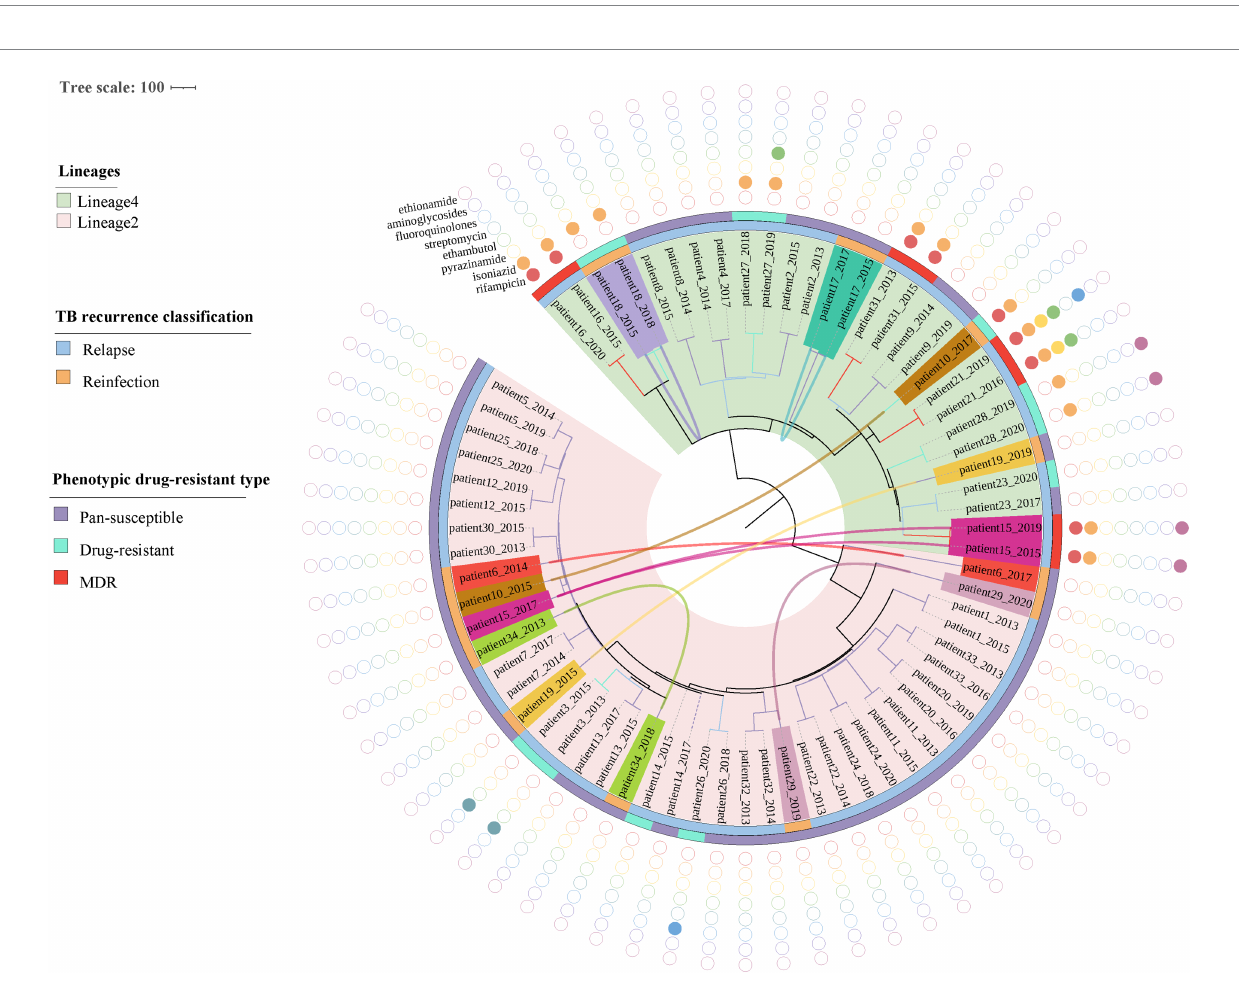
FIGURE 3 Phylogenetic tree and drug-resistant profile of 69 MTB strains from 34 recurrent patients. Inner band indicates TB recurrence classification (reinfection represents strain pairs differences >12 SNPs, whereas relapse represents strain pairs differences ≤ 12 SNPs) and the outer band suggests phenotypic drug-resistant type (see legend). Solid circles indicate genetic drug resistance detected by TB-profiler. Reinfected patients are highlighted with different colors and curves connecting patients’ samples in the phylogeny indicating paired strains isolated from the same